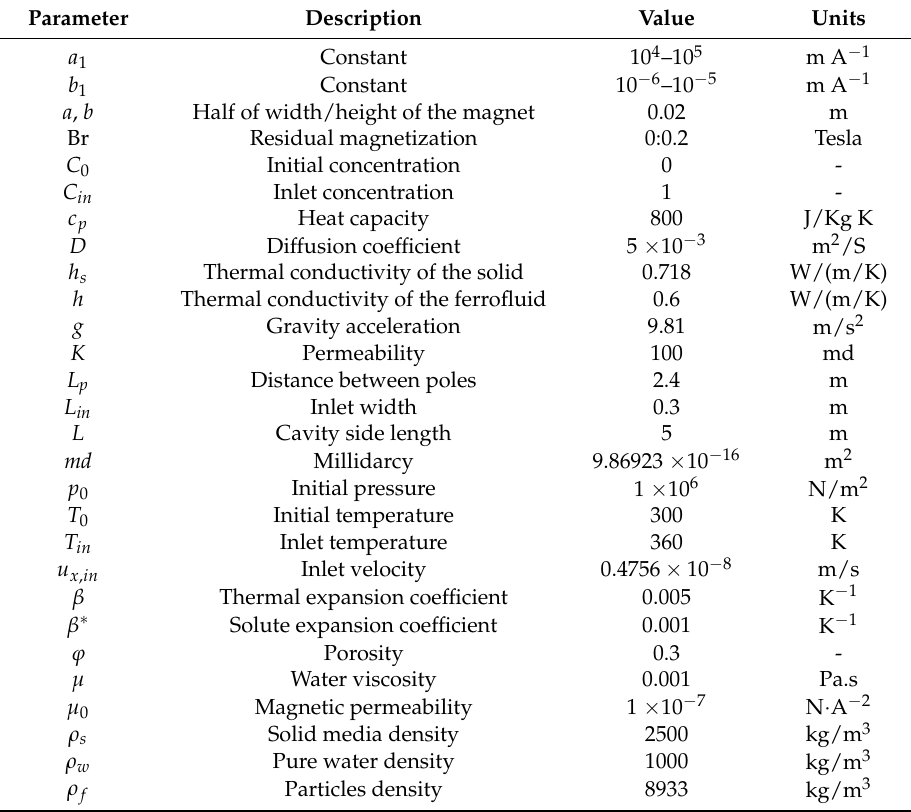
Table 1. Physical parameter